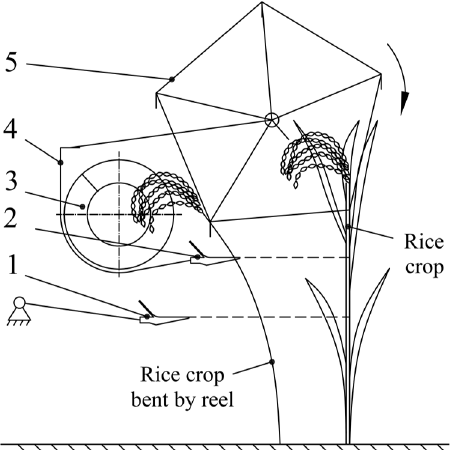
Figure 1. Diagram of a double-cutterbar structure. (1) Lower cutterbar, (2) upper cutterbar, (3) auger, (4) header frame, (5) reel.